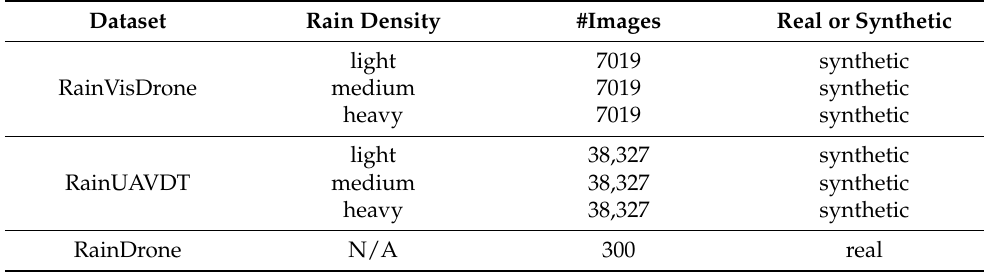
Table 2. Overview of our drone-captured rainy image datasets.